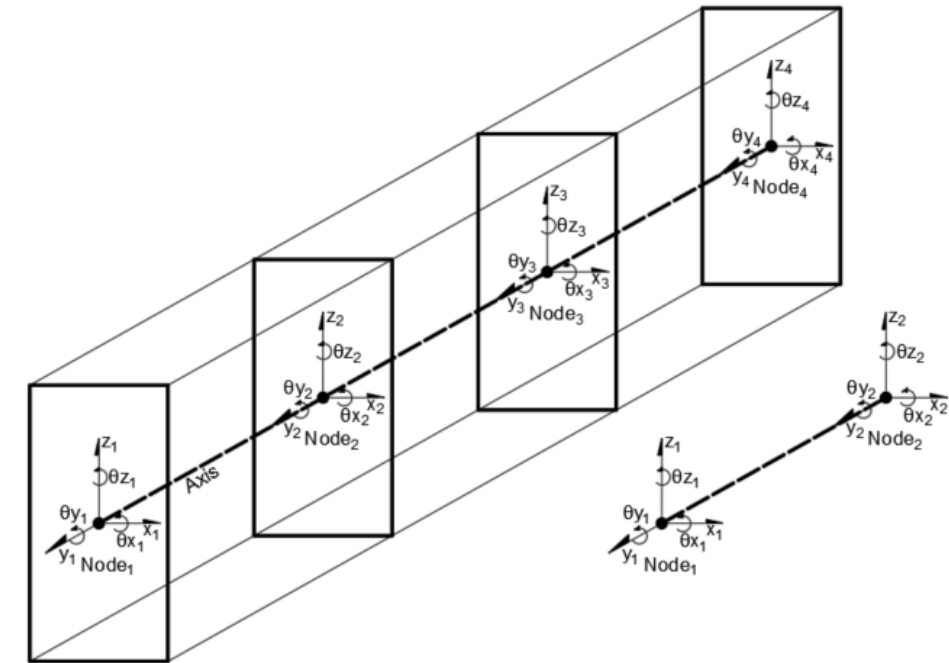
Figure A3. Timoshenko FE schema (6 DOF per